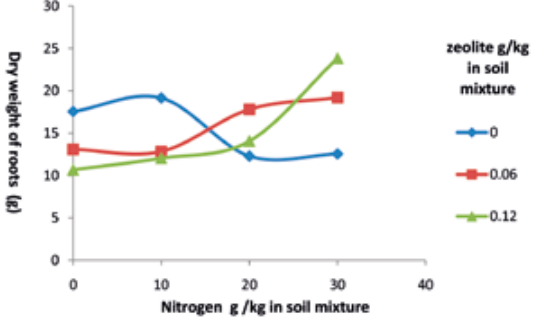
* In each column and row means followed by the same letter(s) (small letters for means and capital letters for means of rows and columns) are not significantly different using LSD test at 5%